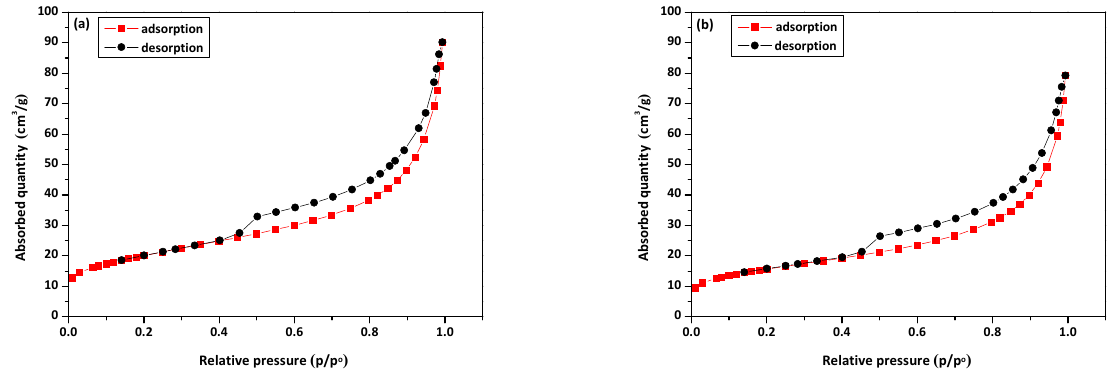
Figure 4. Nitrogen adsorption/desorption isotherms at 77K for ( a ) NaP1 and ( b ) NaP1CS after sorption of Cu(II) and phenol.